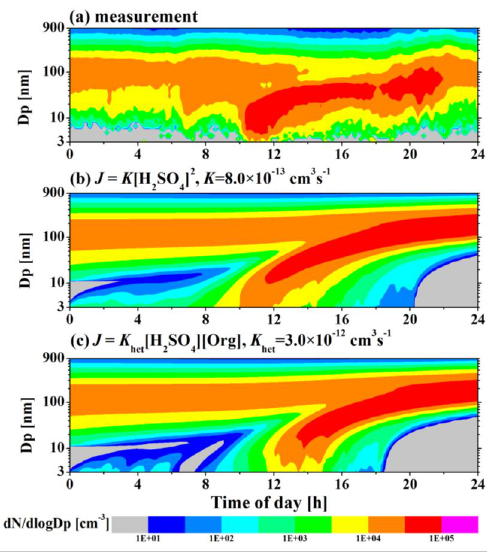
872 Figure 5. Measured and modelled particle number size distributions on September 12. (a) : measurement; (b) : 873 Fig. 5. Measured and modelled particle number size distributions on modelled with kinetic nucleation mechanism; (c) : modelled with homogenous heteromolecular kinetic nucleation 874 12 September: (a) measurement, (b) modelled with kinetic nucle- mechanism. 875 ation mechanism, and (c) modelled with homogenous heteromolec- ular kinetic nucleation